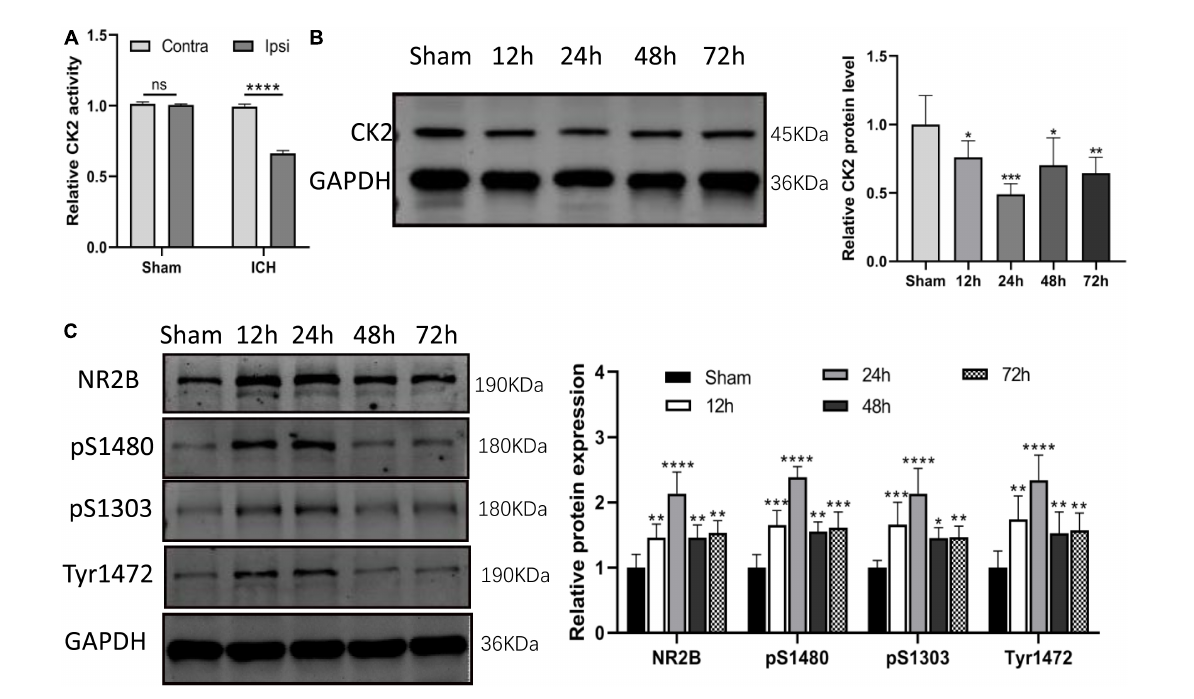
FIGURE2 CK2 was downregulated in the brain tissues of ICH rats. (A) The CK2 activity in ipsilateral and contralateral hemisphere of sham and ICH groups ( n = 3). (B) Expression of CK2 were determined 12, 24, 48, and 72 h after ICH in rats using Western blot. (C) Expression of NR2B, NR2B phosphorylation sites S1480, S1303, and Tyr1472 were determined 12, 24, 48, and 72 h after ICH in rats using Western blot ( n = 6). Data were expressed as mean ± SD. * p < 0.05, ** p < 0.01, *** p < 0.001, **** p <